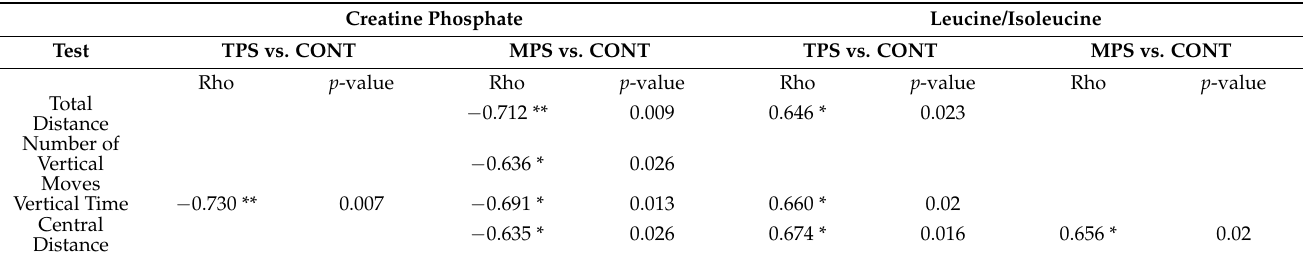
Table 2. Spearman’s rank correlations of blood plasma metabolite concentrations of creatine phos- phate and leucine/isoleucine in relation to open field (OF) behavioural measurements. Correlation coefficients were obtained utilizing metabolite concentrations from comparisons of non-stressed (CONT) versus multigenerationally-stressed (MPS) Long-Evans rats and non-stressed (CONT) versus transgenerationally-stressed (TPS) Long-Evans rats. *—indicates a correlation with a p -value less than 0.05; **—indicates a correlation with a p-value less than 0.01. Creatine Phosphate